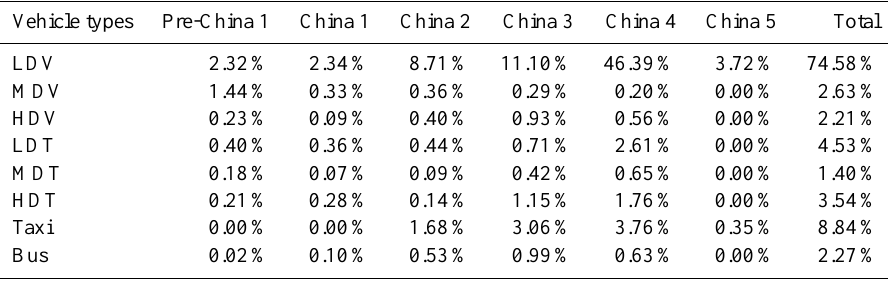
Table 1. Fleet composition in Beijing.